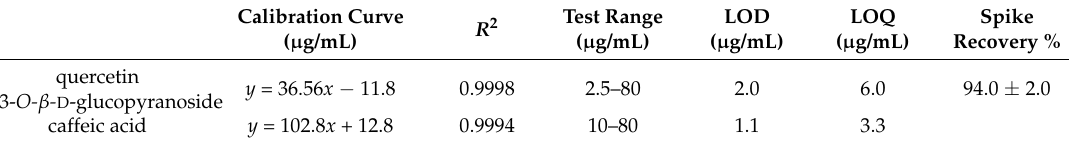
Table 5. Calibration curve, LOD and LOQ for quercetin 3- O- β - D -glucopyranoside ( ≥ 90%, Sigma Aldrich) and caffeic acid ( ≥ 98%,